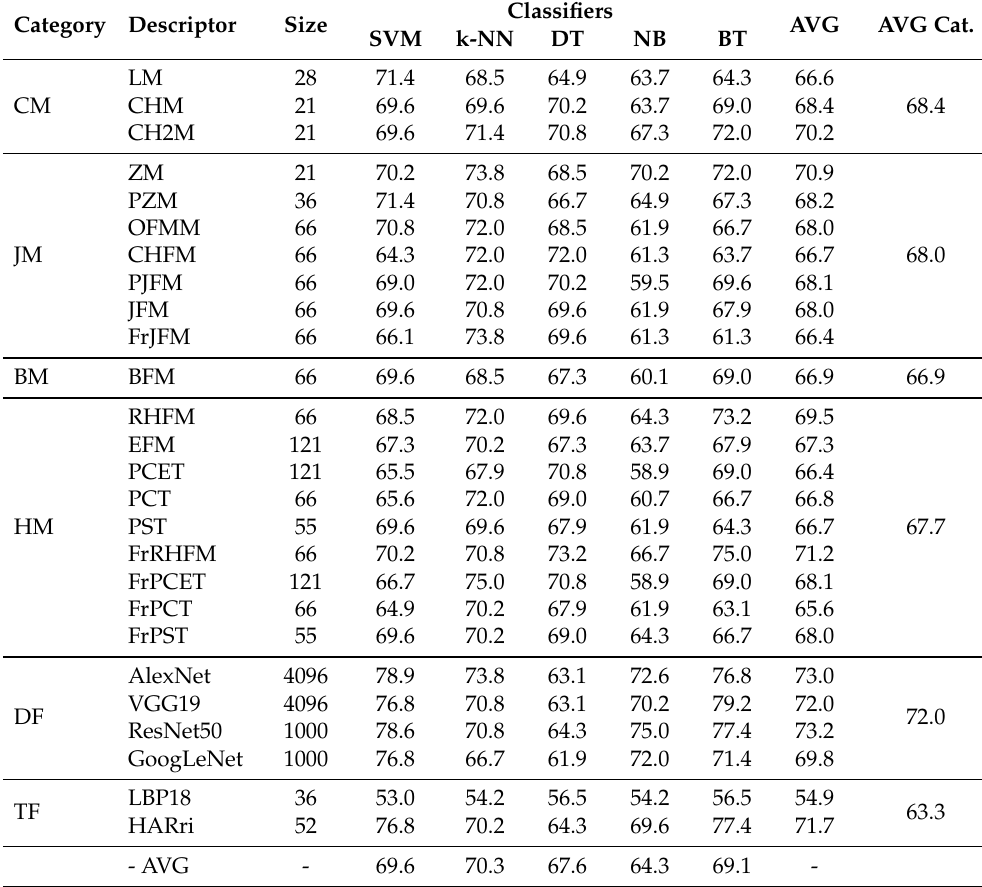
Table 3. Results obtained on the Emphysema-CT data set with all the analysed features, for which we report the categorisation (category column, CM—Cartesian moments, JM—Jacobian moments, BM— Bessel–Fourier moments, HM—harmonic moments, DF—deep features, and TF—texture features), the name (descriptor column), the feature size (size column), the accuracy obtained with all the tested classifiers (SVM, k-NN, DT, NB, BT columns), and the average accuracy value (AVG column). On the right (AVG cat.), we also report the average accuracy value of each category of features and on the bottom (AVG row), we report the average accuracy per